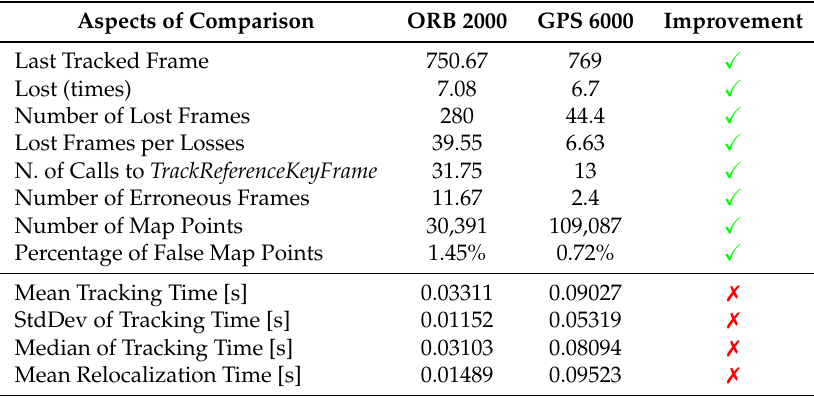
Table 5. Comparison table for the best adjustments for both algorithms.